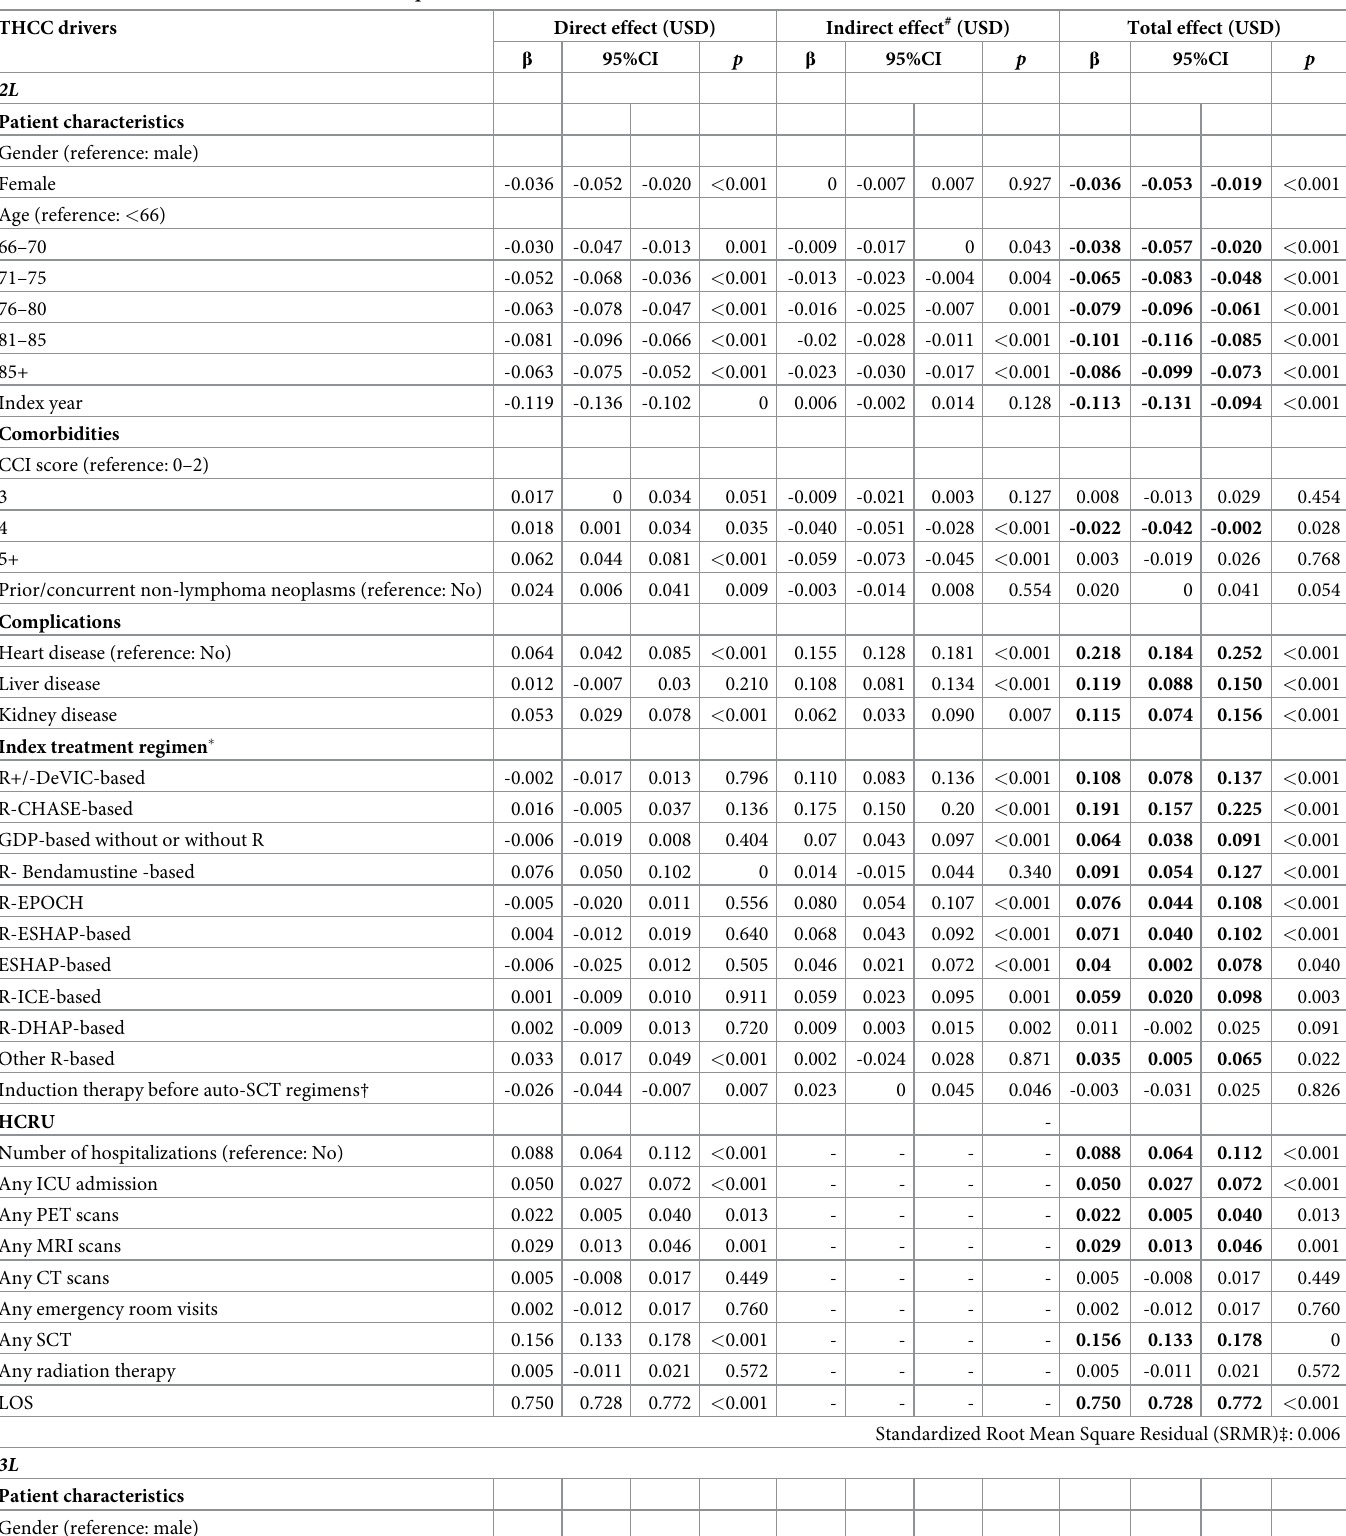
Table 4. Standardized estimates from structural equation model of 2L and 3L cost